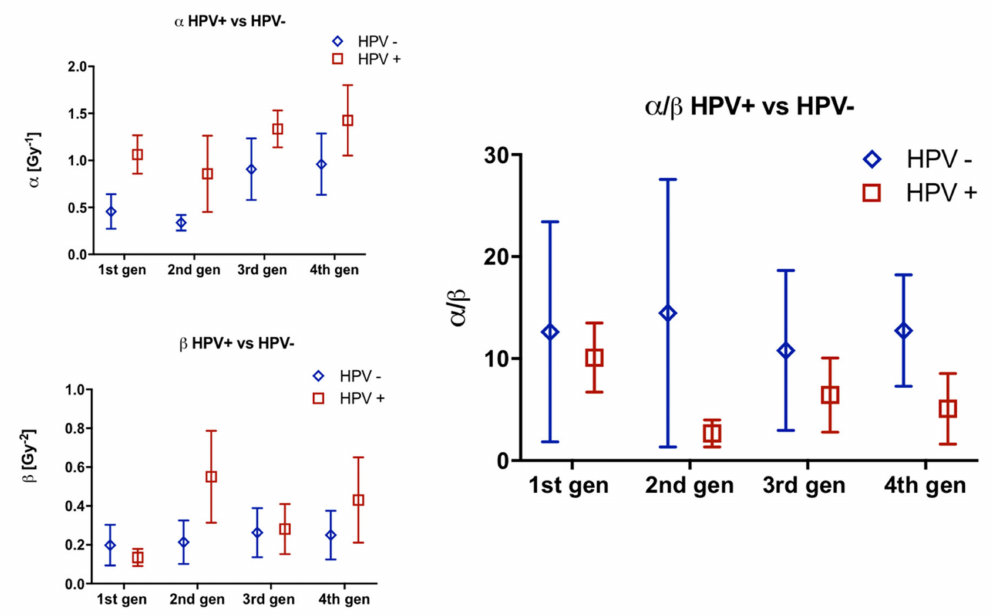
Figure 6. Comparison of α , β and α / β ratios by HPV group for 4 generations. Error bars represent